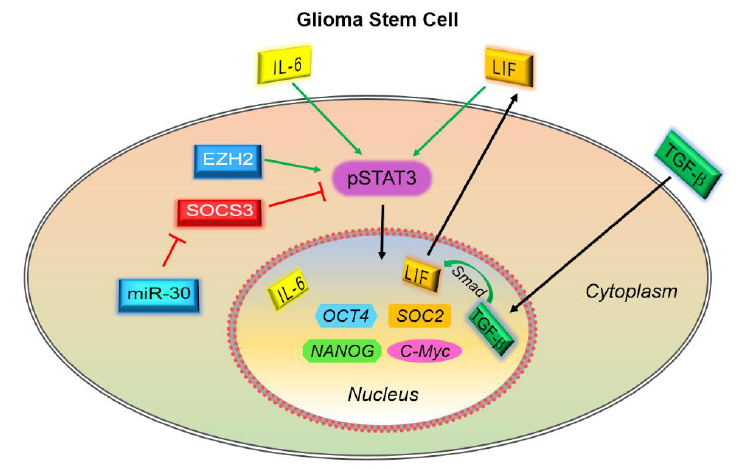
Figure 3. STAT3 activation in glioma stem cells. A number of dysregulated extra- and intra-cellular signaling pathways lead to constitutive STAT3 activation in glioma stem cells, which